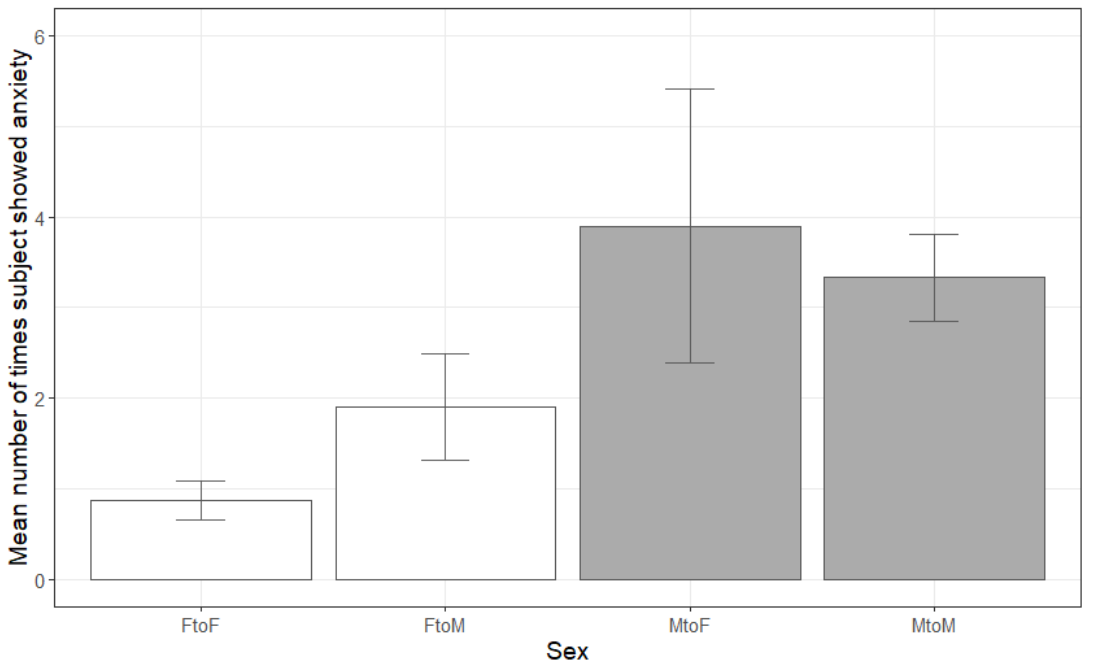
Table 1. Estimates from the Poisson regression for the number of intervals during which an indi- vidual was attentive to the iPad during the Zoom session.